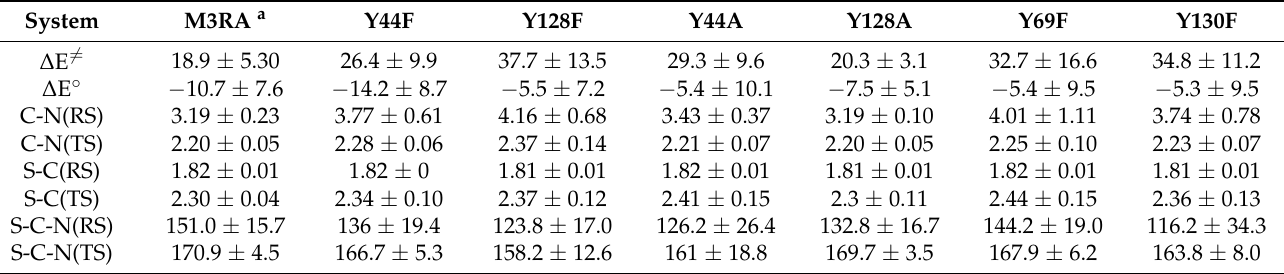
Table 1. Barrier heights ( ∆ E (cid:54) = ), reaction energies ( ∆ E 1 ◦ ), and selected average geometric parameters with their corresponding standard deviations for the RS and TS conformations of the mono-methyl- transfer reaction in the native enzyme M3RA and mutants Y44F, Y128F, Y44A, Y128A, Y69F, and Y130F. Average activation and reaction energies are in kcal/mol, distances in Å, and angles in degrees ( ◦ ).